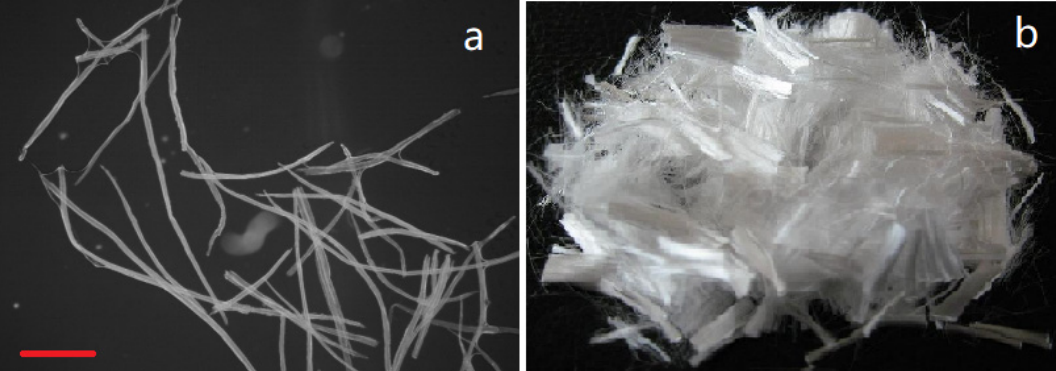
Figure 1. The Fibers used for composites in this experiment. ( a ) Hemp hurd/wood mixture fibers (Bar: 200 μ m); ( b ) PP fibers.